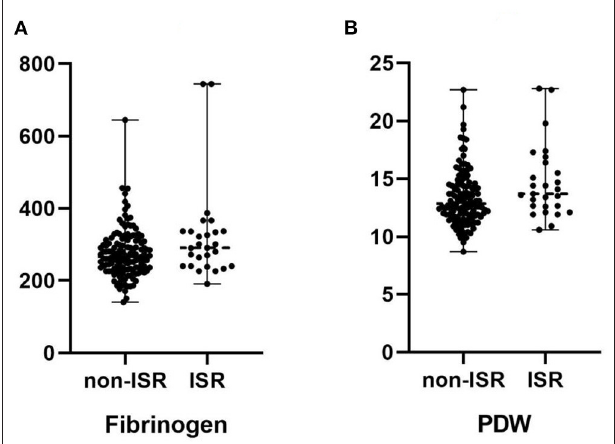
FIGURE 2 | (A) Comparison of the median fibrinogen in patients with and without in-stent restenosis. (B) Comparison of the median platelet distribution width (PDW) in patients with and without in-stent